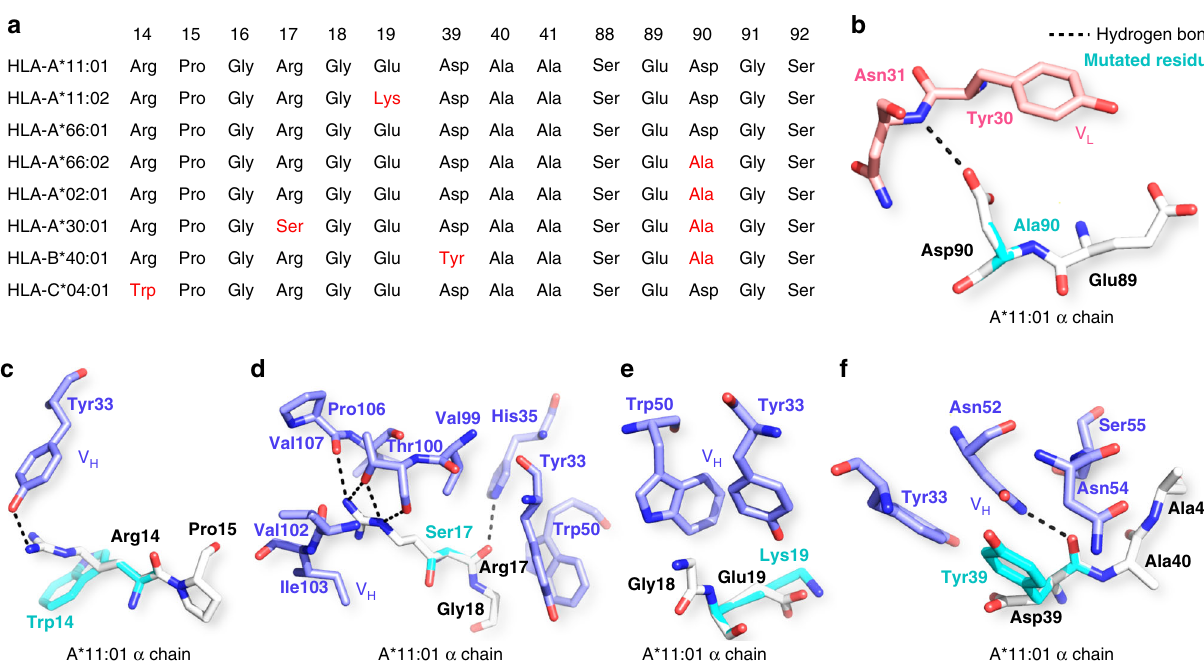
Fig. 3 Structural analysis of 2E3 allele speci fi city. a Amino acid sequence alignment of HLA-A*11:01 with selected HLA alleles at the 2E3 epitope. b Magni fi ed view of the interaction between HLA α chain Asp90 and 2E3 V L . Asp90 was duplicated and mutated to Ala90 (cyan). c Magni fi ed view of the interaction between HLA α chain Arg14 and 2E3 V H . Arg14 was duplicated and mutated to Trp14 (cyan). d Magni fi ed view of the interaction between HLA α chain Arg17 and 2E3 V fi ed view of the interaction between HLA α chain Glu19 and 2E3 V H . Arg17 was duplicated and mutated to Ser17 (cyan). e Magni H . Glu19 was duplicated and mutated to Lys19 (cyan). f Magni fi ed view of the interaction between HLA α chain Asp39 and 2E3 V H . Asp39 was duplicated and mutated to Tyr39 (cyan). HLA human leukocyte